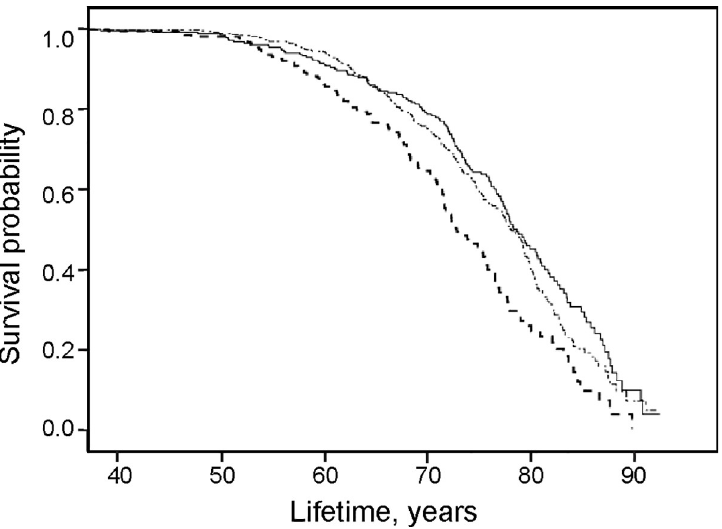
Fig 4. High all-cause mortality with a high BMI in males. Survival probability for all-cause mortality in males with BMI 27 . 6–34 . 2 ( � ─ � � ─ � ─ � ), BMI < 27 . 6 ( ───── ) and BMI > 34 . 2 (-—-—- -) illustrated with results from Kaplan- Meier analysis.